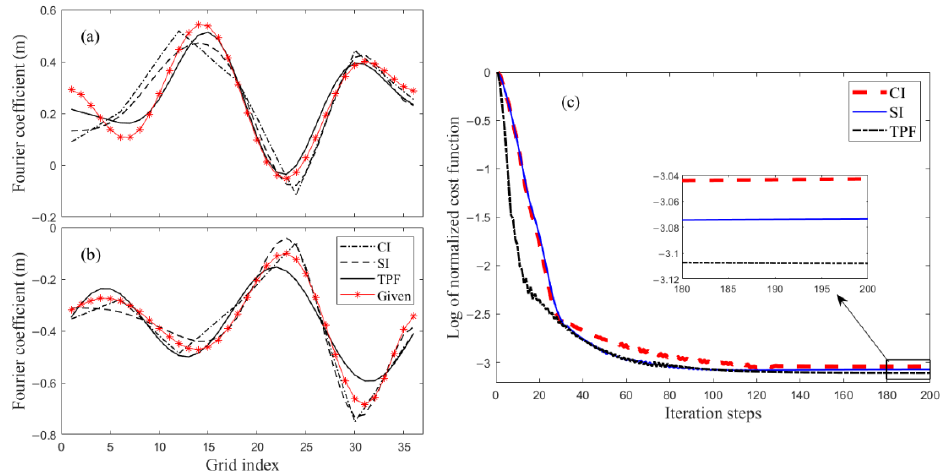
Figure 7. Prescribed and inverted FCs α ( a ) and β ( b ) and the descent process with iteration steps for the normalized cost function ( c ) of control experiment.